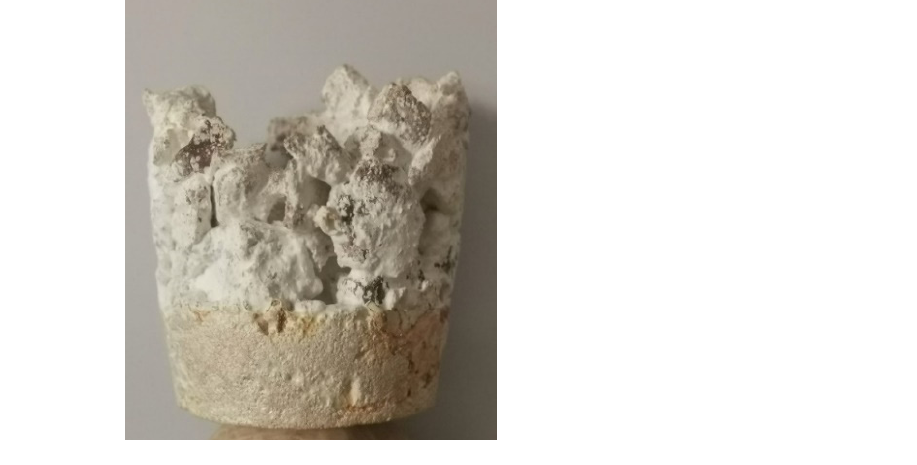
and photo: A. Bonenberg).